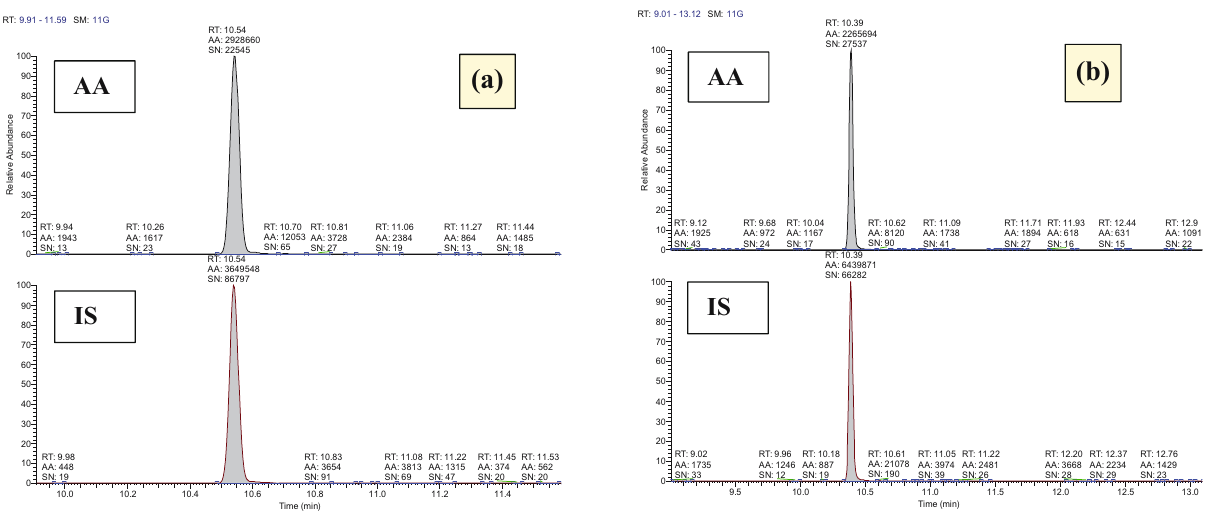
Figure 3: Chromatogram of chips ( a ) and French fries ( b ) samples obtained with the SPE procedure developed. AA – acrylamide peak, IS – labeled AA